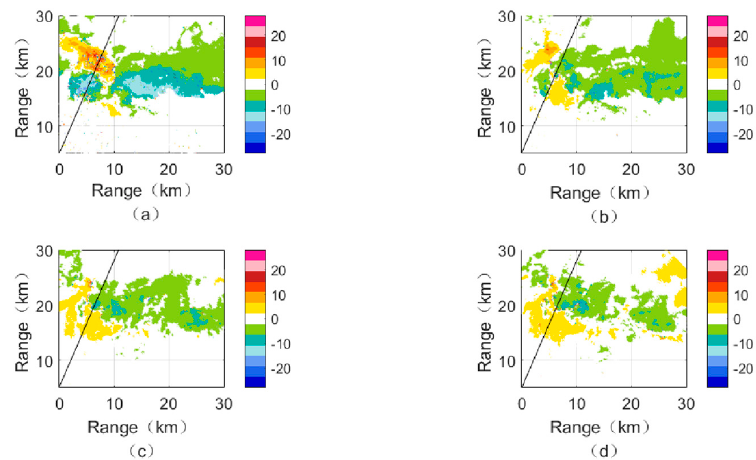
Figure 5. Plan Position Indicator (PPI) scans of radial wind speed (m/s) at ( a ) 0.5°; ( b ) 2.9°; ( c ) 5.3°; ( d ) 6.5° elevations at 20:23–20:25 UT on 30 July 2017. Black lines represent the radar radial line.